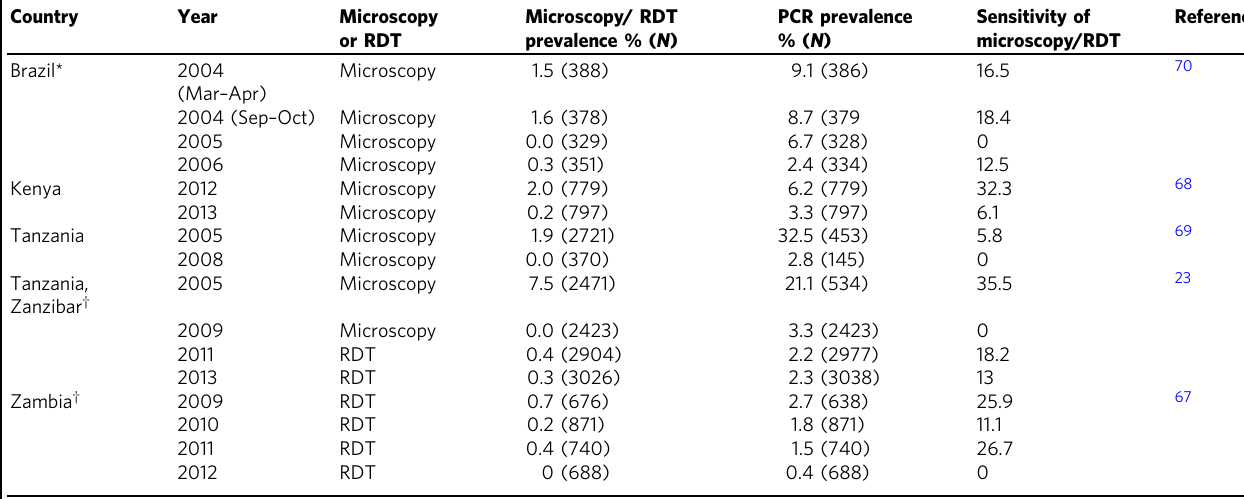
Table 2 Sensitivity of microscopy or RDT compared with PCR in areas with declining transmission